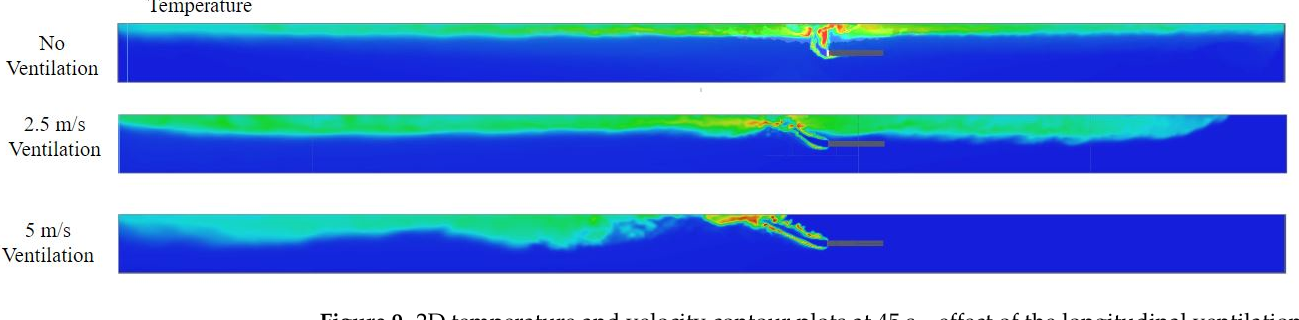
Figure 9. 2D temperature and velocity contour plots at 45 s—effect of the longitudinal ventilation velocity (Cases 2, 5, and 6). The colour code is the same as in Figure 7.